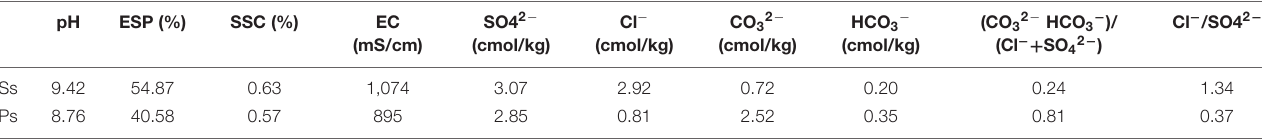
FIGURE 1 | The habitats of S. salsa community and P. tenuiflora community: (A) S. salsa community; (B) P. tenuiflora community. TABLE 1 | The values of soil indicators of S. salsa community and P. tenuiflora community.